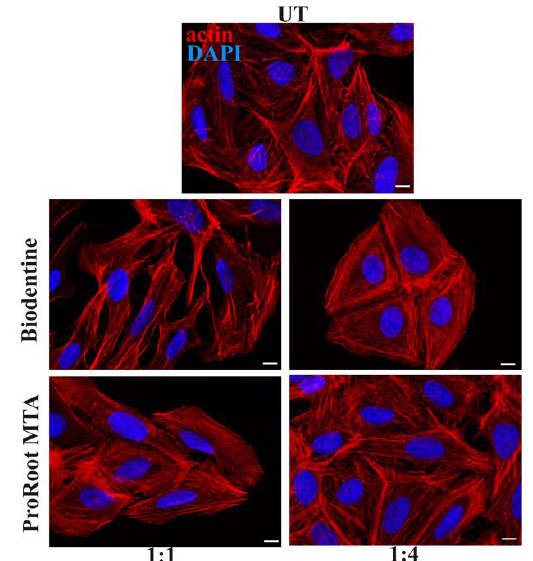
Figure 4. Immunofluorescence analysis of cytoskeletal actin performed on Saos-2 cells after exposure to Biodentine or ProRoot MTA extracts, respectively. UT: untreated sample. Scale bars represent 10 µ m.